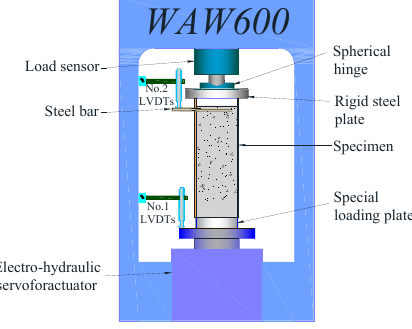
Figure 4. Push-out test setup.